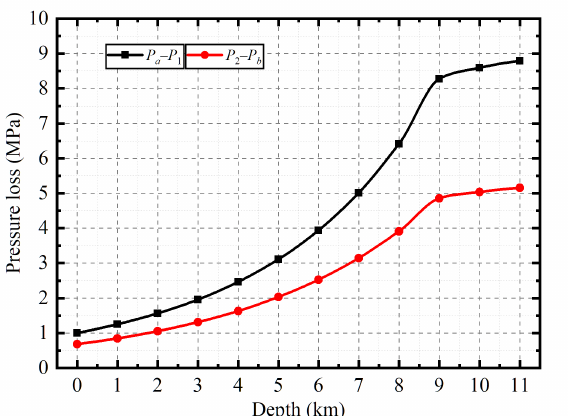
Figure 11. Pressure losses in slender pipelines at 8 s when the hydraulic cylinder is extending, whereas the meaning of each symbol is the same as that in Figure 1.